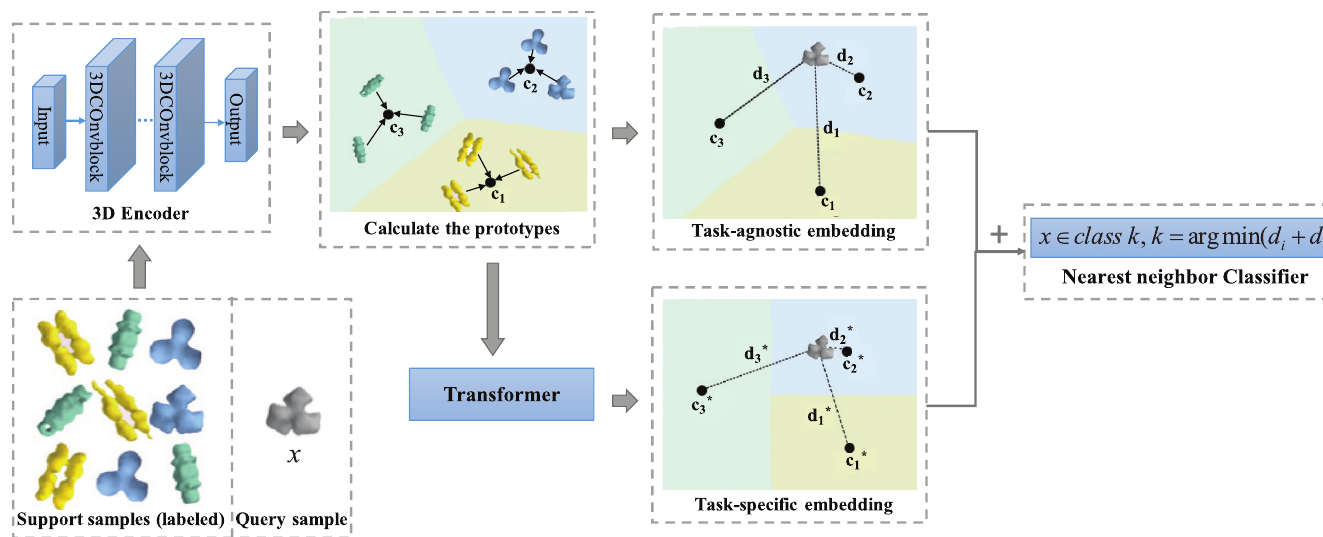
Fig 1. The flowchart of our method. Suppose we have a support set with three classes and three labeled samples of each class. Firstly, each support sample is mapped into a task-agnostic embedding space through a 3D encoder and the prototype of each class is calculated. Then a task-specific embedding space is generated through a transformer to focus more on the current classification task, with another set of prototypes calculated. The query sample x is mapped to both embedding spaces respectively and the distances between x and prototypes in both embedding spaces are combined as the classification criteria using a nearest neighbor classifier.